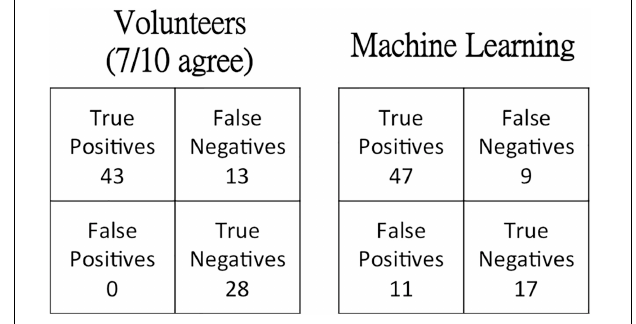
FIGURE 3 | Confusion matrices for citizen scientists’ and the machine-learning algorithm’s classifications.